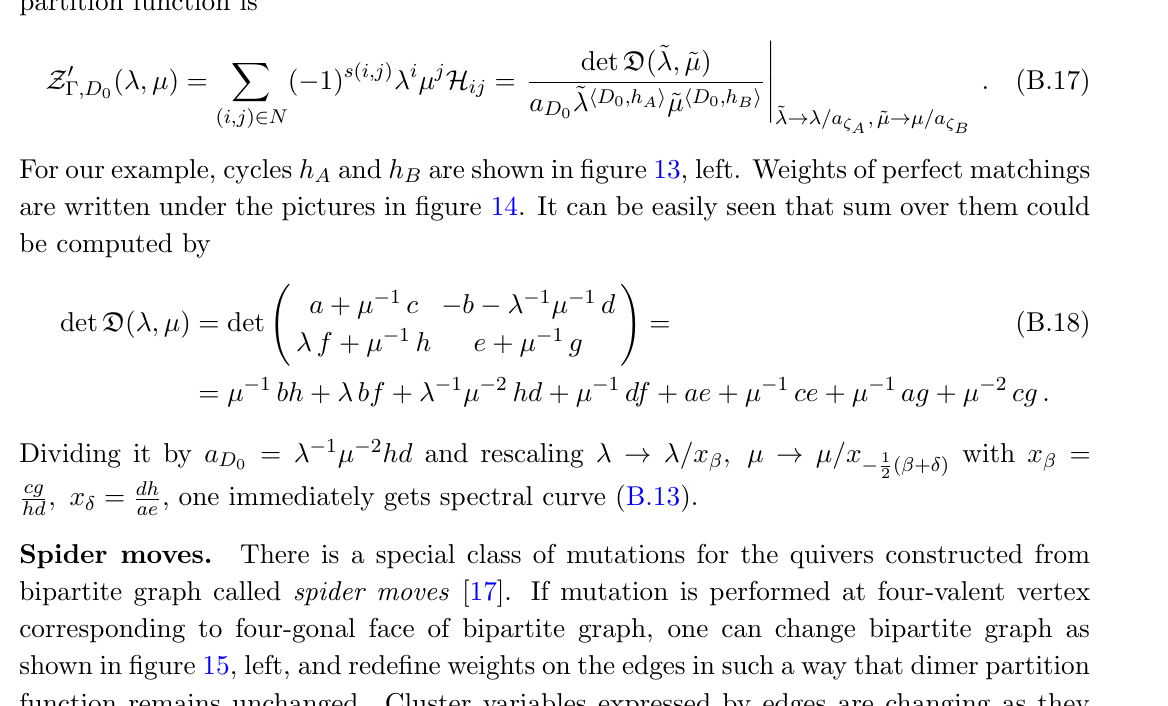
Figure 15 . Left: transformation of bipartite graph under spider move. Right: mutation of quiver under spider-move. We draw only the edges, connecting 1 ; 2 ; 3 ; 4 with 0, a(cid:11)ected by the mutation. and B cycles on T 2 . Precise relation between determinant of Kasteleyn operator and